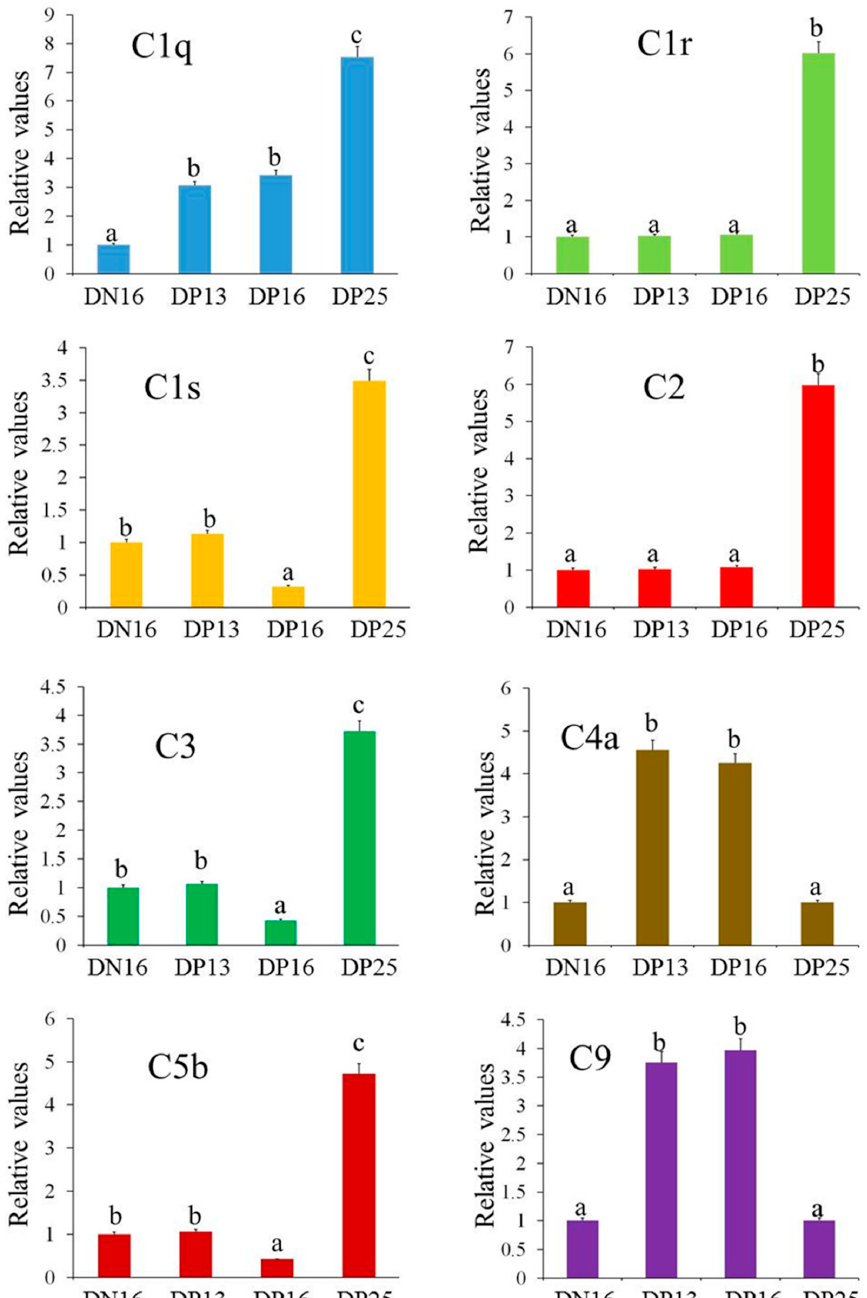
Figure 1. Relative expression levels of complement component mRNA in the spleen. Note: DN16 = day 16 of the estrous cycle; DP13 = day 13 of gestation; DP16 = day 16 of gestation; DP25 = day 25 of gestation. Significant differences ( p < 0.05) are indicated by different letters.